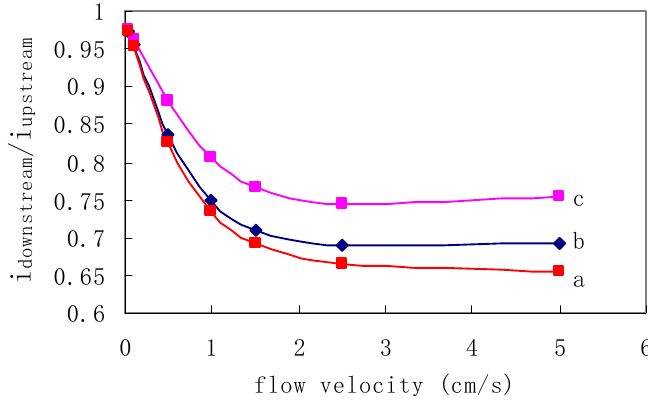
Figure 2. The relationship between the flow rate and the ratio of currents between upstream working electrode and downstream working electrode, i distance between two working electrodes is 100 nm, while for curve b and c, the distances are 200 nm and 400 nm, respectively. Flow rate is the flow velocity at the center of the